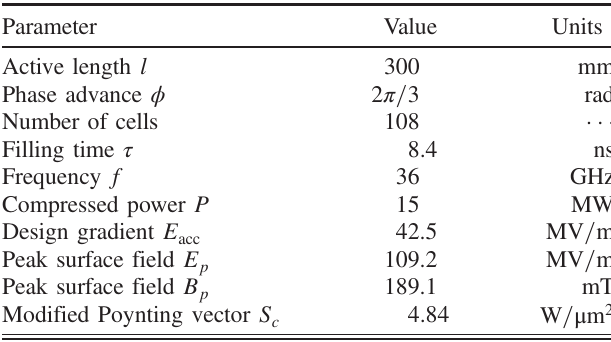
TABLE III. TWS parameters at nominal voltage.